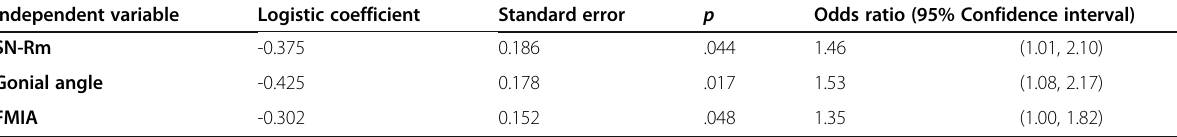
Table 7 Logistic regression models using cephalometric variables for the unstable group a Independent